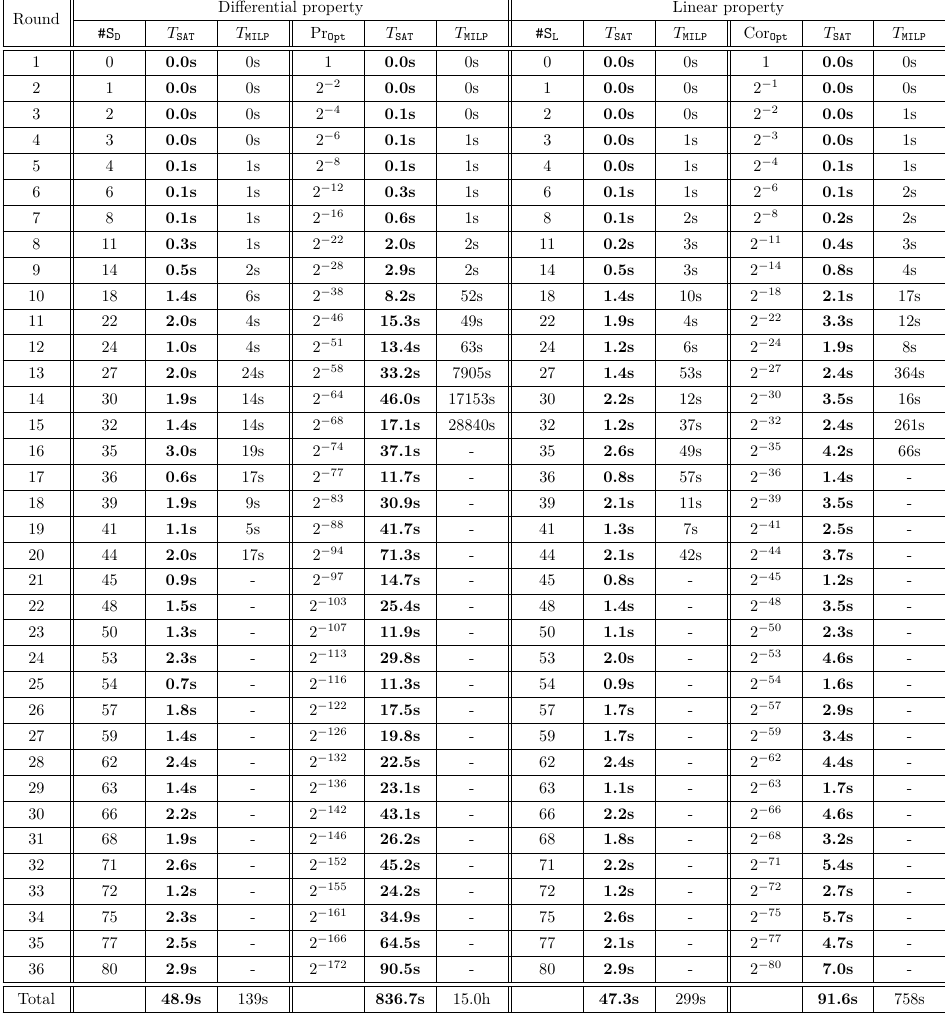
Table 8: Experimental results of TWINE